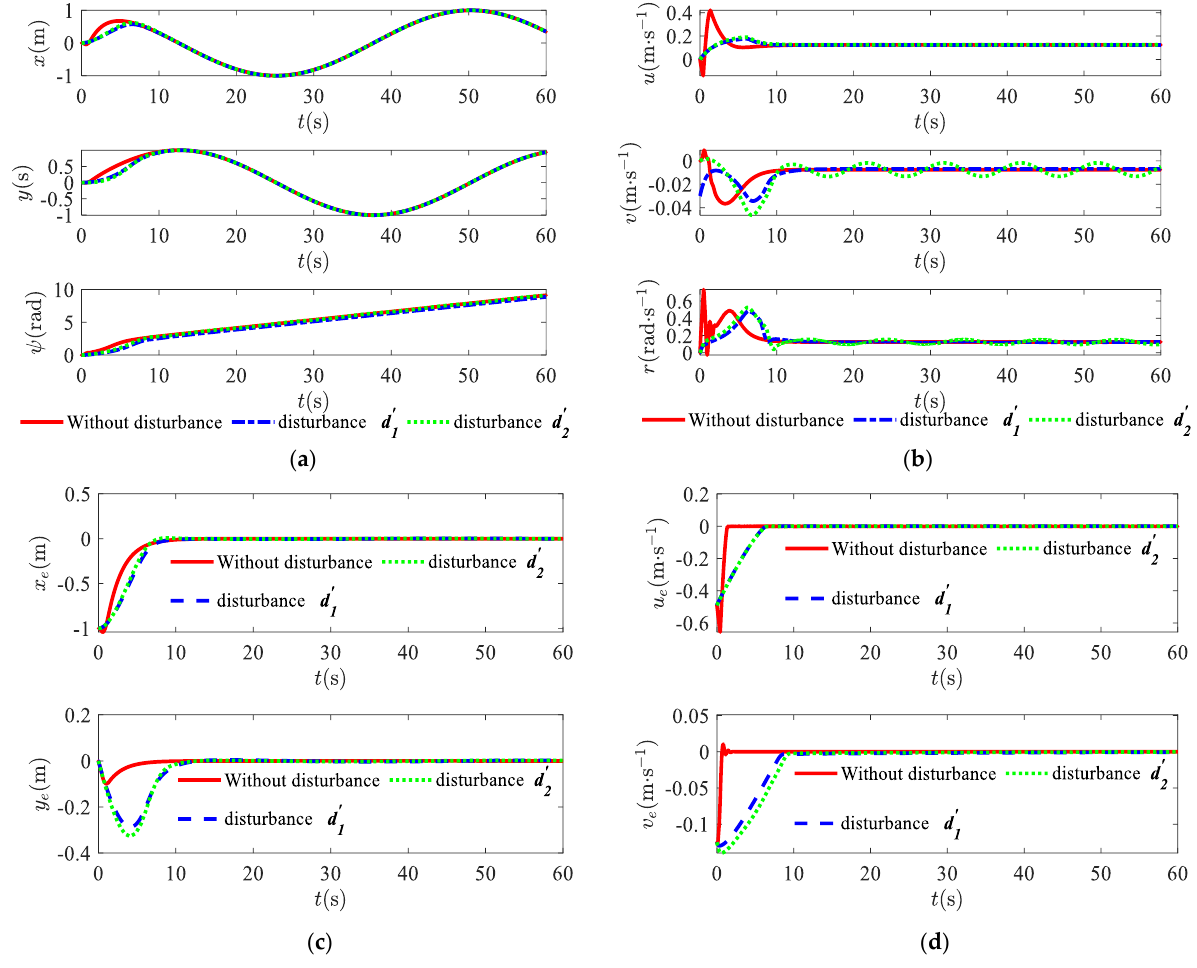
Figure 7. Position and velocity curves: ( a ) the actual position of USV in three cases; ( b ) the actual velocity of USV in three cases; ( c ) position tracking errors in three cases; ( d ) velocity tracking errors in three cases.